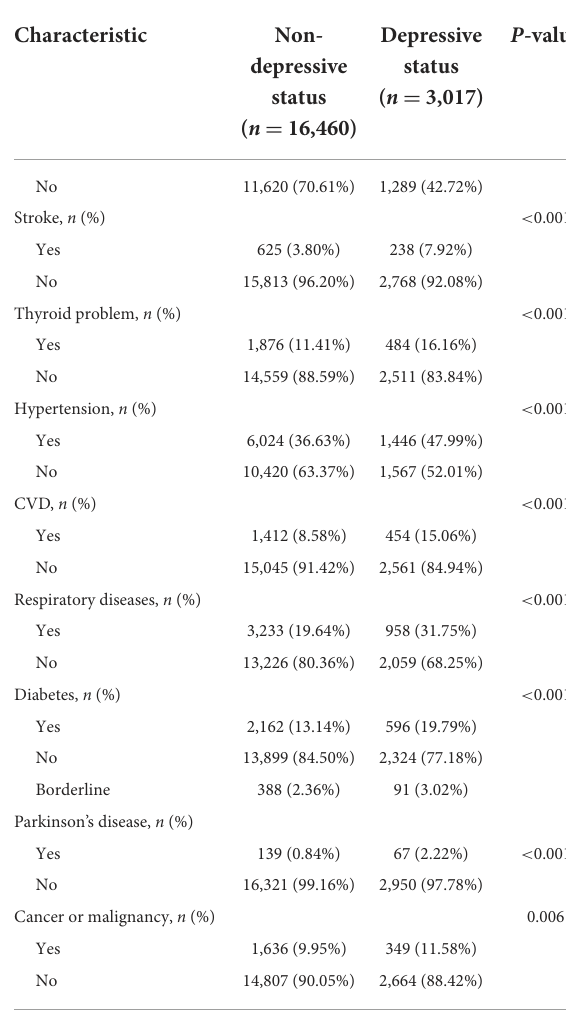
TABLE 1 Baseline characteristics of selected participants of NHANES 2005–2018 ( n =